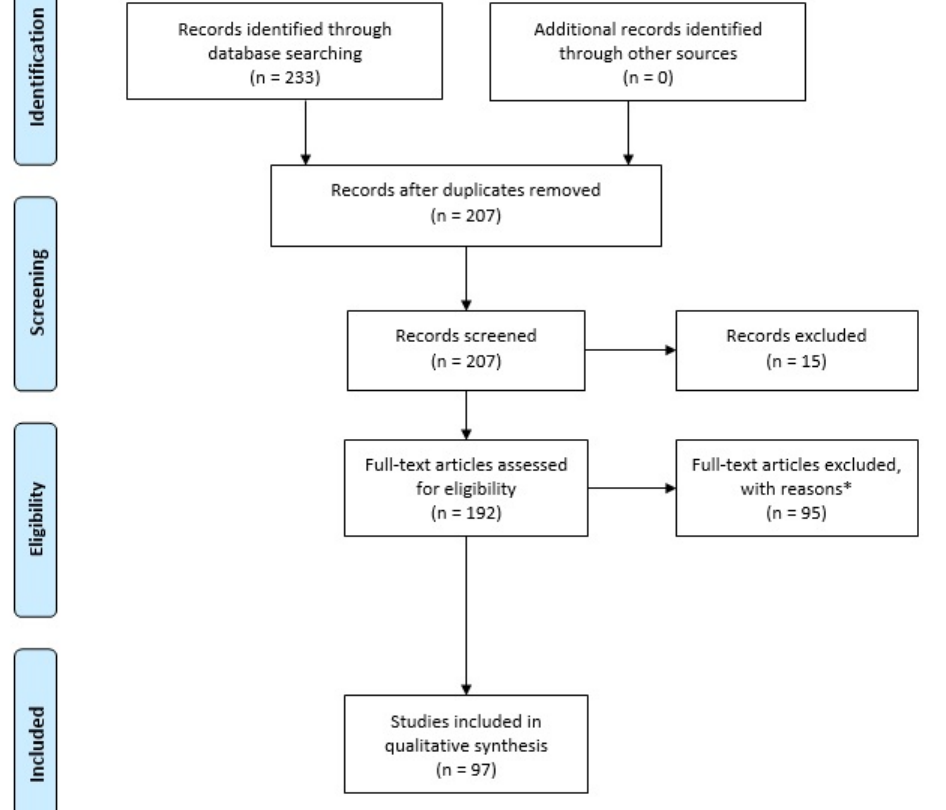
Figure 1. PRISMA flow diagram. * Full-text articles were excluded due to the following reasons: (1) the articles did not report data for individual comparison groups; (2) the articles did not distinguish NAFLD and